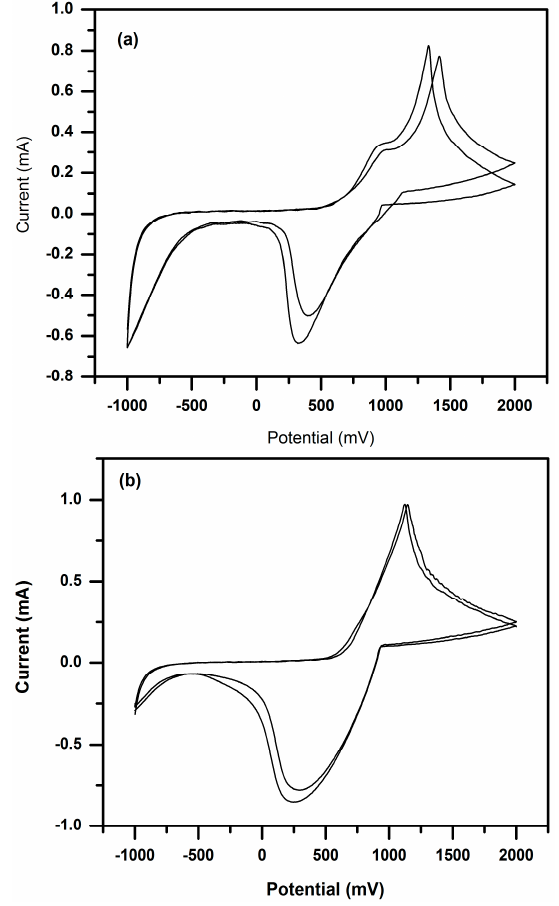
Figure 4. Cyclic voltammetry (CV) plots of ( a ) P(3HT- co -3TAA); ( b ) Urs/P(3HT- co -3TAA) in 0.1 M LiClO 4 /PC (Potentials are vs. Ag/AgCl/3.4 M KCl reference.).